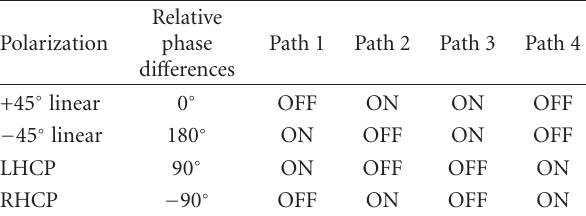
Table 1: Control paths for polarization reconfigurations. Polarization